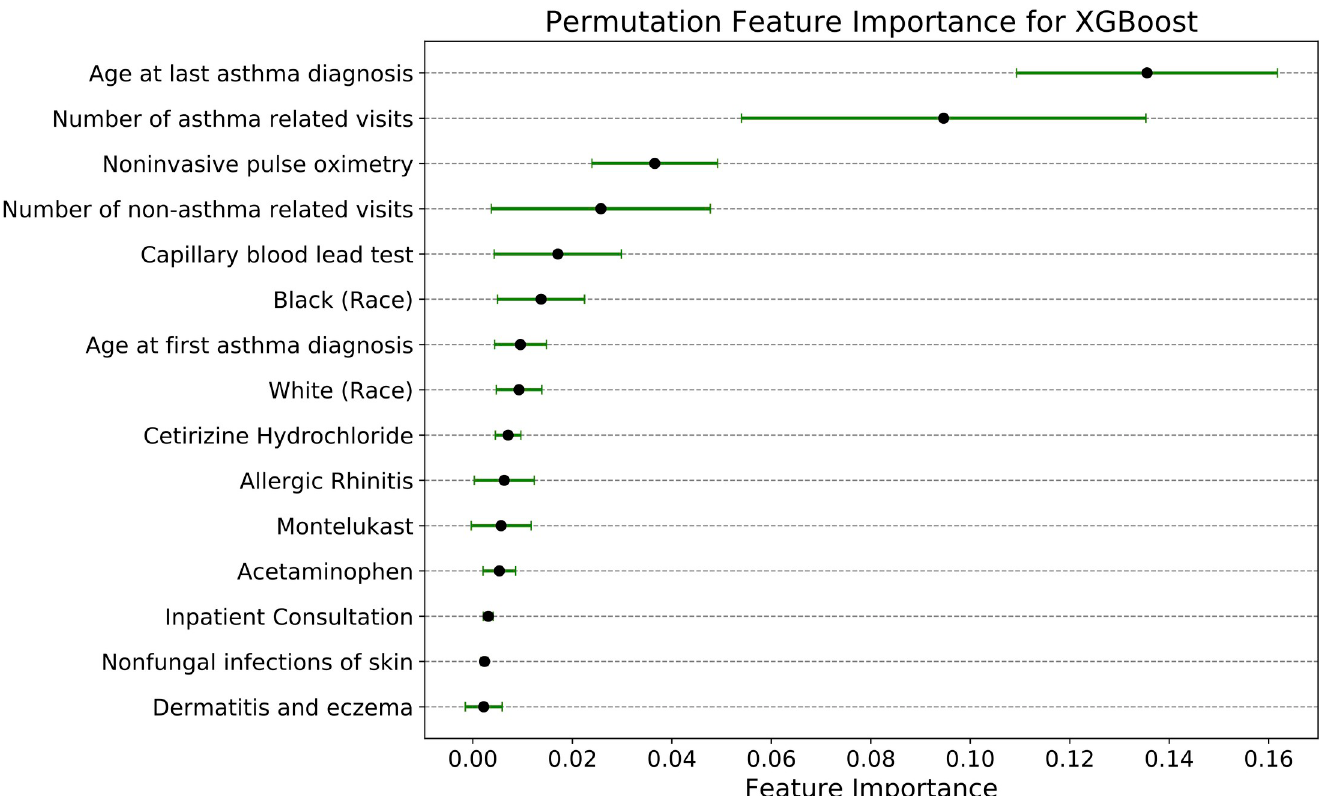
Fig 6. Permutation feature importance scores. The feature importance on the x-axis represents the mean decrease in model performance measured by ANSA when a feature is removed.